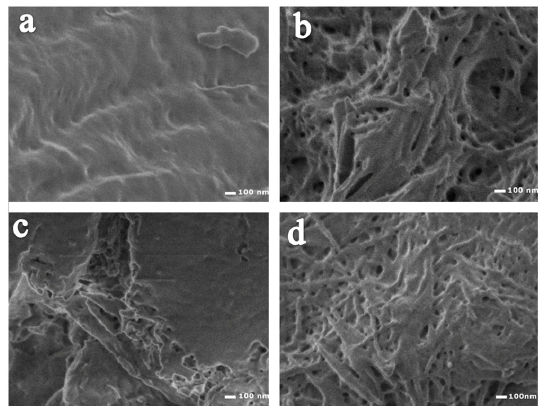
Figure 5. SEM images (10,000×) of microcrystalline cellulose ( a ) and microcrystalline cellulose loaded with alanine and phenylalanine ( b ), proline and alanine ( c ), or proline and phenylalanine ( d ).